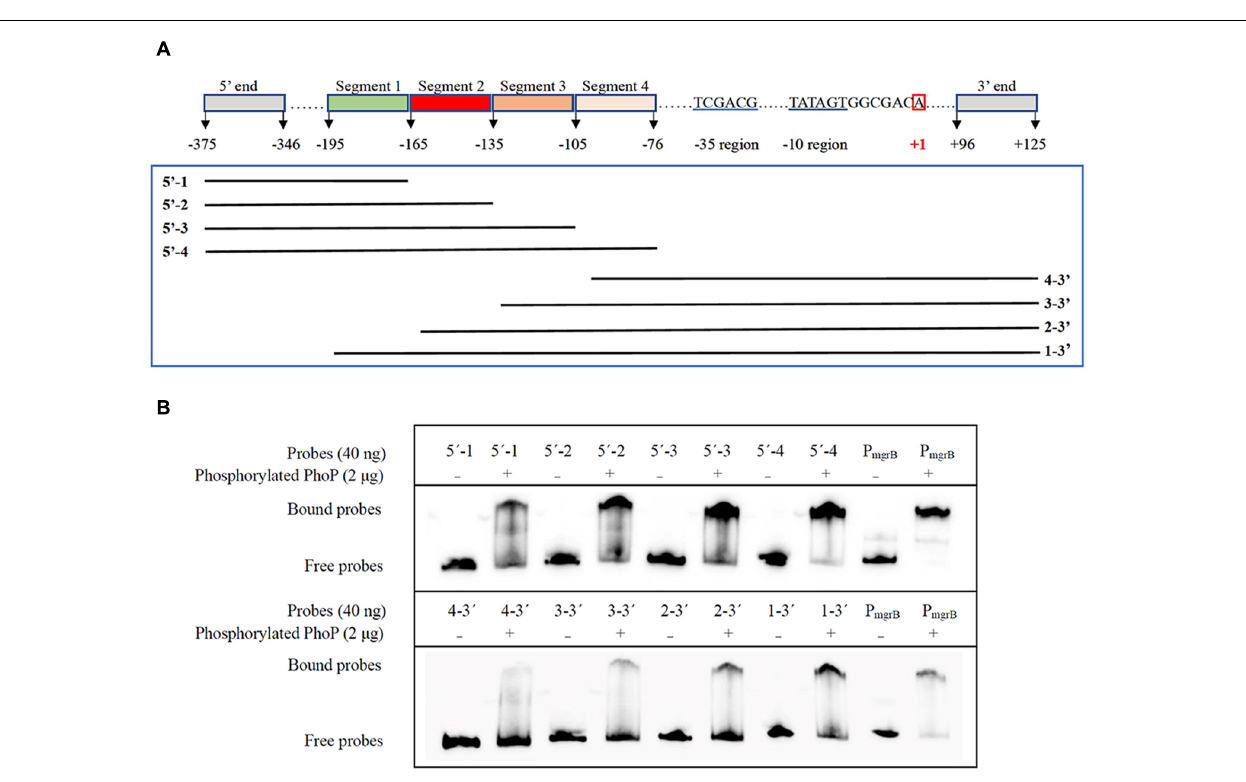
Frontiers in Microbiology |